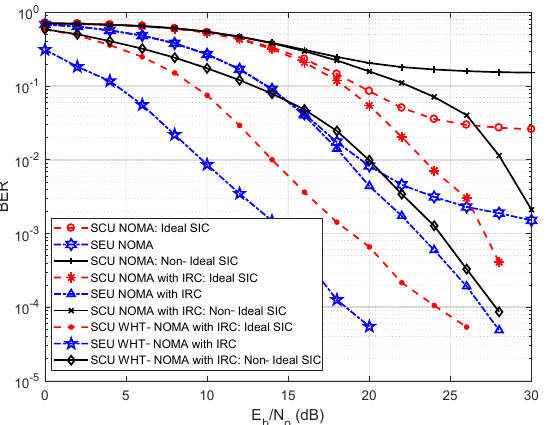
Figure 16. BER performance with IRC using QAM modulation; NOMA vs. WHT–NOMA, power